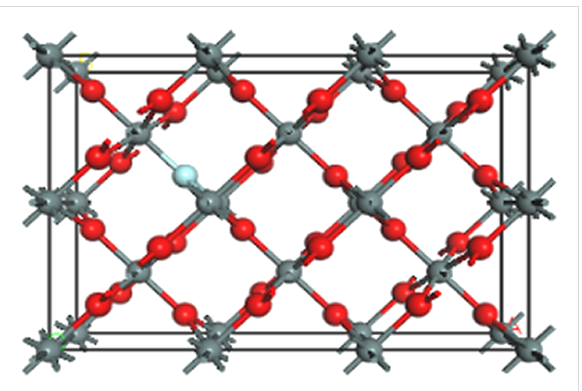
Figure 1: Schematic diagram of the structure of a non-metal atom replacing an O atom in a SnO 2 unit cell (The red spheres are oxygen atoms, the gray spheres are tin atoms, and the light blue sphere is the non-metal